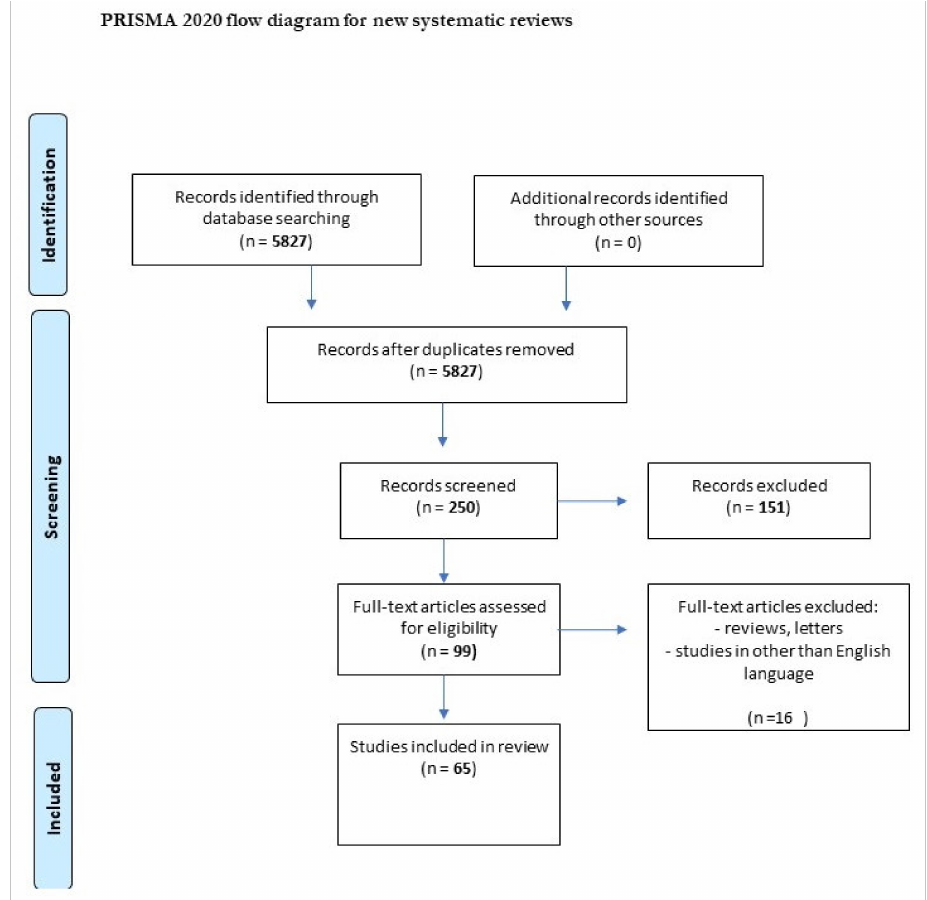
Figure 1. PRISMA flow diagram.